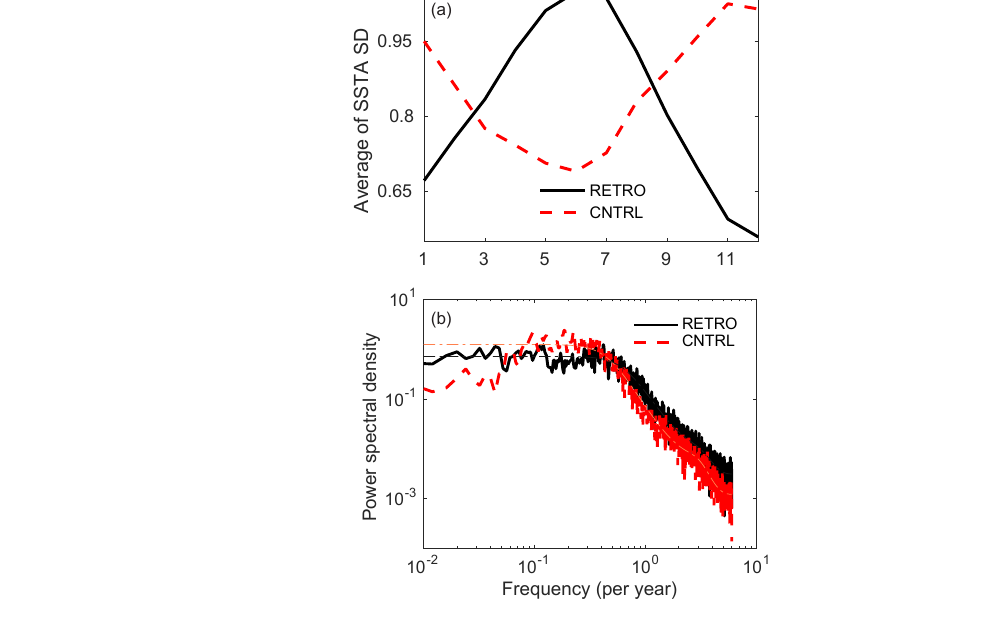
Figure A3. SSTA indices: (a) seasonality of Niño3.4 (CNTRL, black) and INDINO (RETRO, averaged over 10–0 ◦ S, 50–70 ◦ E; red), and (b) the respective power